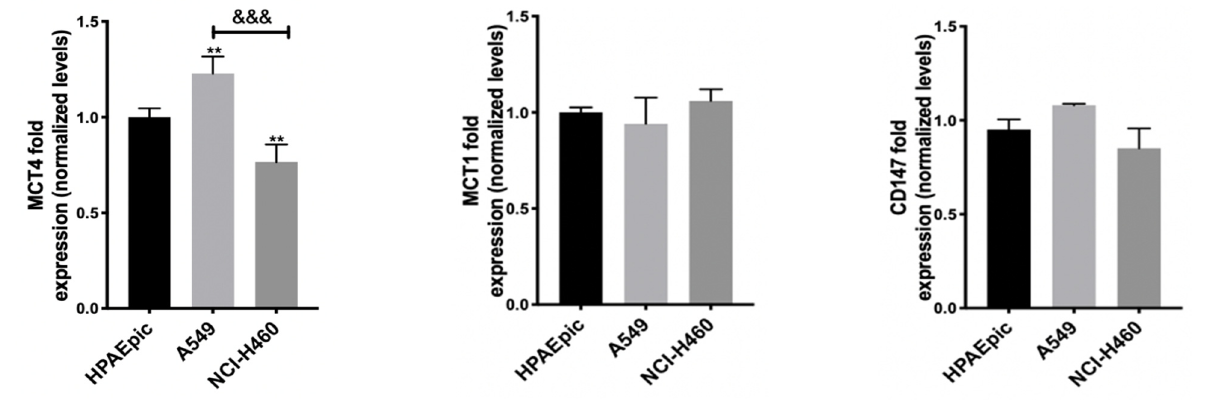
Figure 1. MCT1, MCT4 and CD147 expression analysis in HPAEpic, A549 and NCI-H460 cell lines, assessed by Western blot. The noncancerous cell line HPAEpic presenting a normal phenotype was used as a reference. Levels of protein expression are relative to the control cells and were normalized against tubulin. The results are presented as means ± SD of two independent experiments. ** p < 0.01 compared to HPAEpic cells (control). &&& p < 0.001 compared to A549 cells. Both the MCT1 and MCT4 transporters and CD147 were expressed in all cell lines,